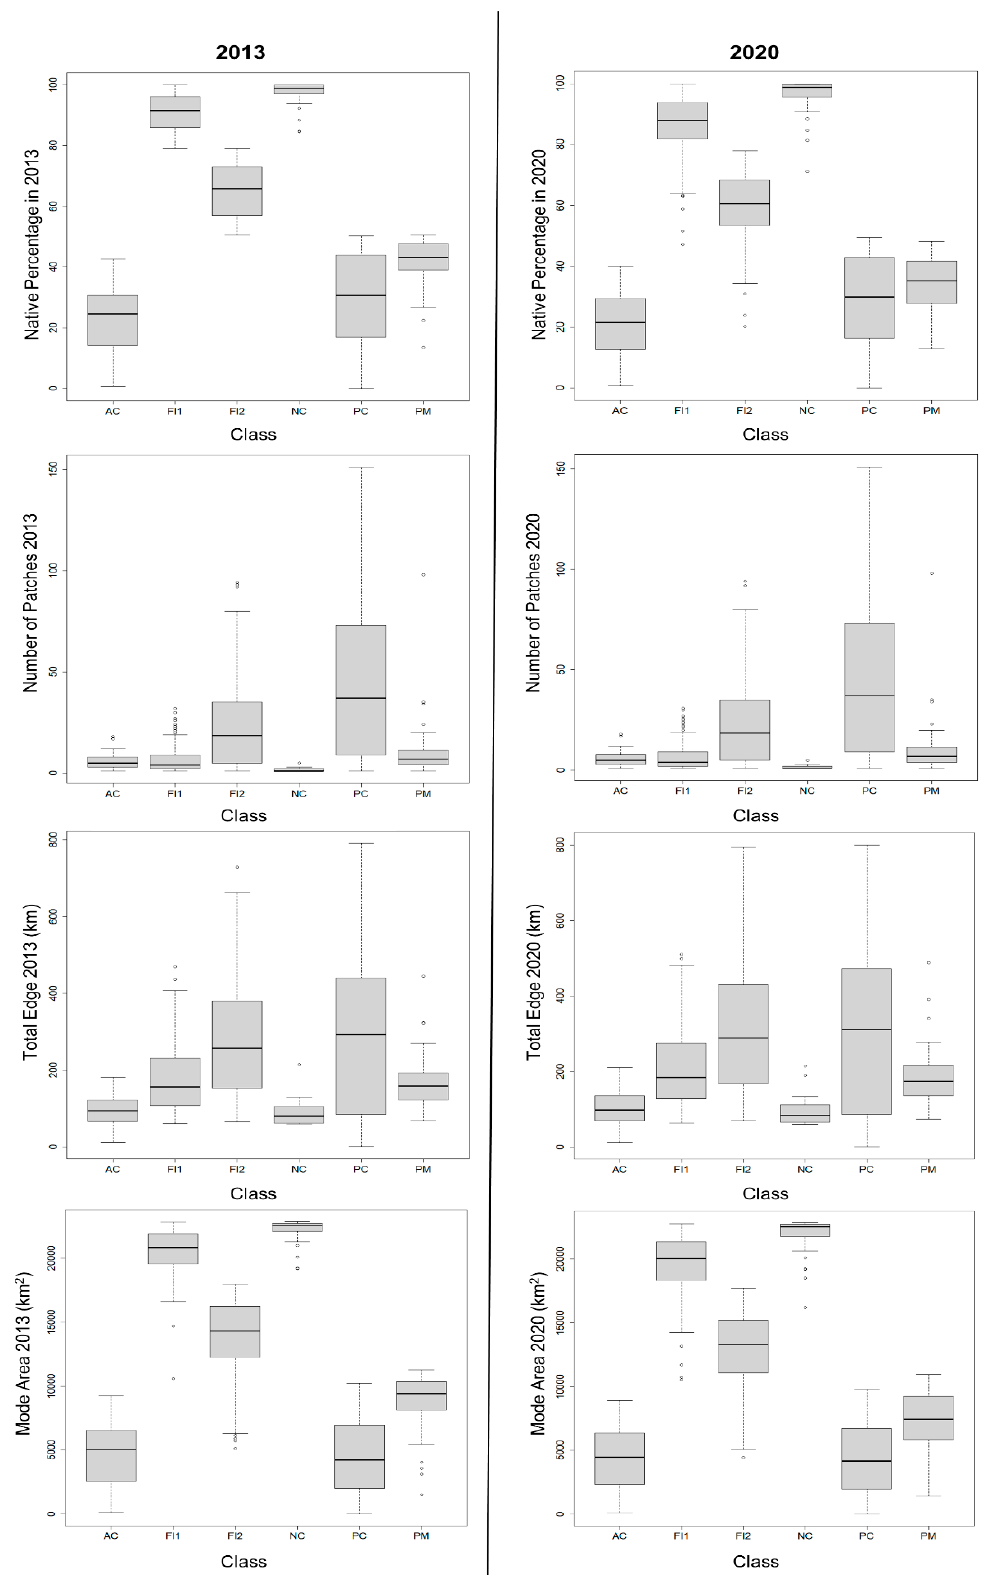
Figure 6. Boxplot of the metrics Native percentage of Cerrado, Patches Number, Total Edge, and Mode Area for each landscape type (AC, FI1, FI2, NC, PC and, PM), in 2013 and 2020. From the results of the Wilcoxon test (W) and T-test (T and p-values), when compar- ing the difference in the native percentage of the Cerrado between the years 2013 and 2020,